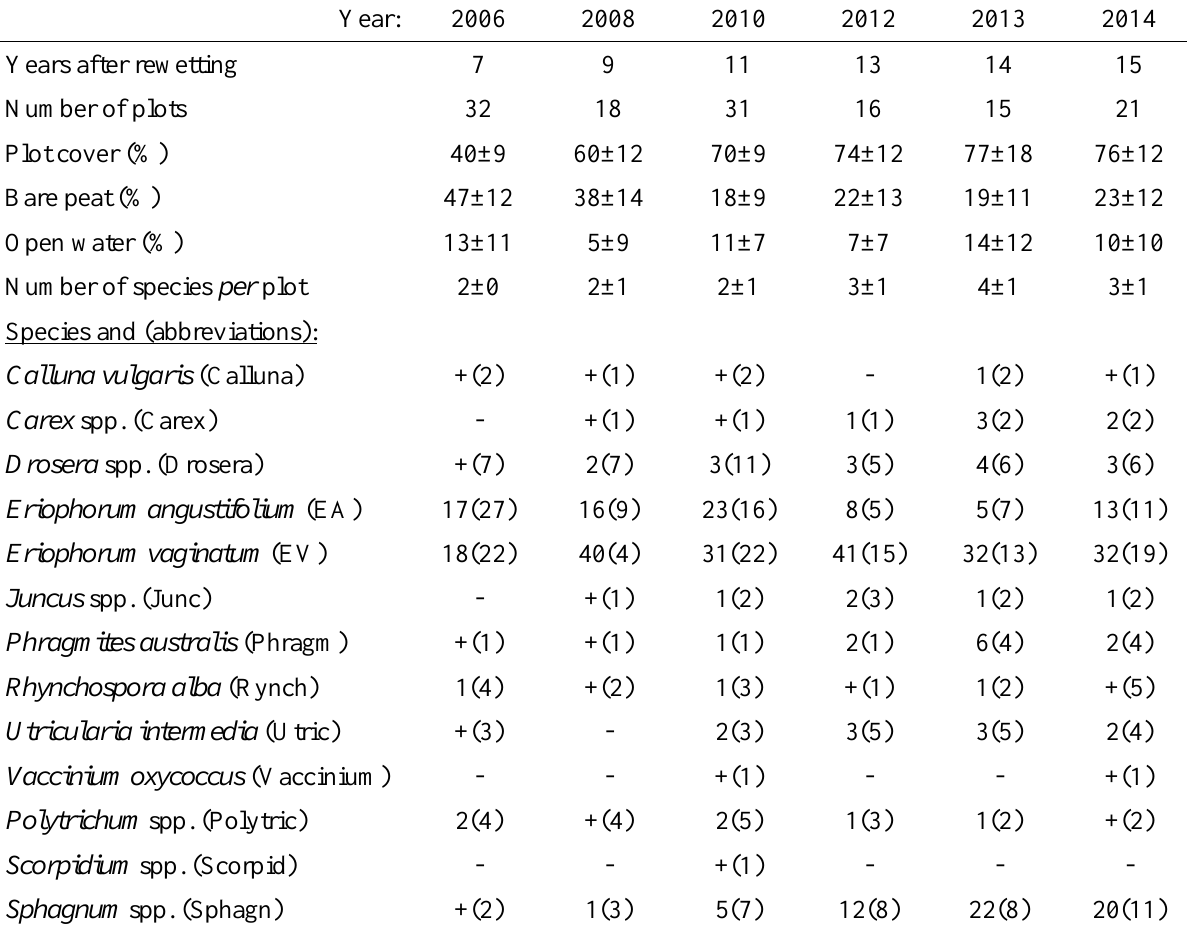
Table 4. Mean cover values (%) recorded through time after rewetting (in 1999) at Porla. Confidence intervals (95 %) are estimated for plot cover, bare peat, open water and number of species per plot. Species are listed in alphabetical order. For each species, mean cover is calculated across all plots and frequency of appearance (number of plots in which the species was recorded) is shown in brackets. "+" = cover less than 1